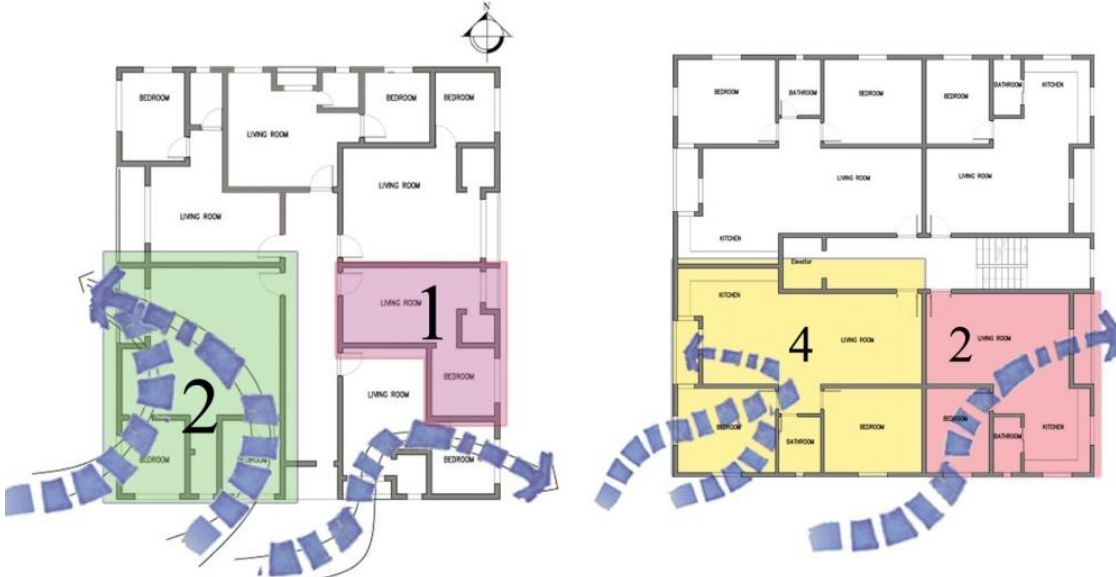
Figure 5. Movement of wind in block C, & block B.